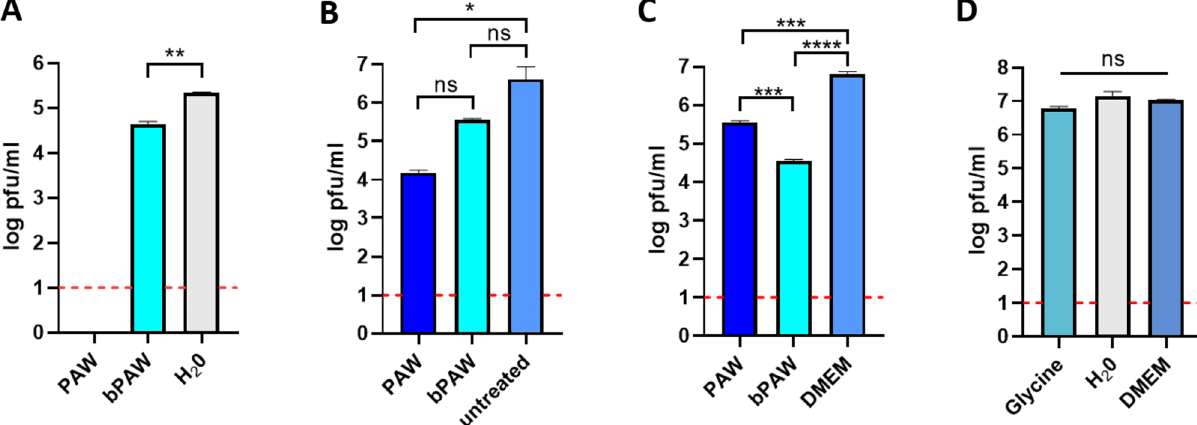
Figure 1. Effect of plasma activated water on SARS-CoV-2 infectivity. The figure depicts representative titration experiments of SARS-CoV-2 inocula subjected to different treatment conditions. ( A ) Mean ± SD viral titers upon incubation with plasma activated water (PAW) or phosphate buffered (bPAW) for 1 h at room temperature. The treated samples were frozen and thawed once before subjected to viral plaque assay on Vero E6 cell monolayers. Distilled water (H20) was used as a non-plasma-activated medium. **: p<0.01 unpaired (two-tailed) t-test (t = 15.22; df = 2). ( B ) Mean ± SD viral titers upon incubation with plasma activated water (PAW) or phosphate buffered (bPAW) for 30 min at room temperature and directly subjected to plaque assay without previous freezing. One-way anova (F = 14.20; p value 0.0295) with Tukey’s post-hoc test. *p<0.05; ns: non-significant. ( C ) Mean ± SD viral titers upon virus adsorption to cells and two consecutive washes with each indicated medium. Dulbecco’s modified Eagle medium (DMEM) was used as washing control. One-way anova (F = 939.4; p value <0.0001) with Tukey’s post-hoc test. ***p<0.001; ****p<0.0001. D. Mean ± SD viral titers upon incubation with media with different pH. One-way anova (F = 8.649; p value 0.0568) with Tukey’s post- hoc test. Ns: non significant. Dotted red line depicts the limit of detection of the plaque assay. Generated with INKSCAPE 1.1 (www. inksc ape.